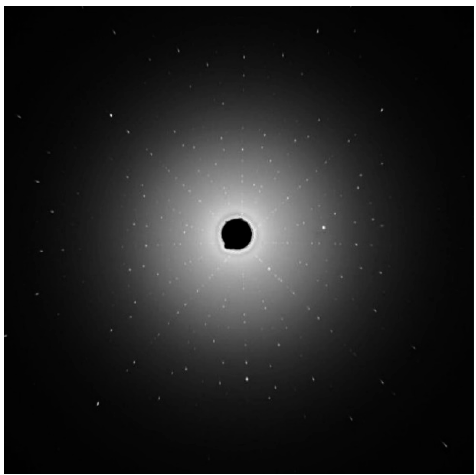
Figure 5. A back-scattered Laue photograph along the [001] axis.